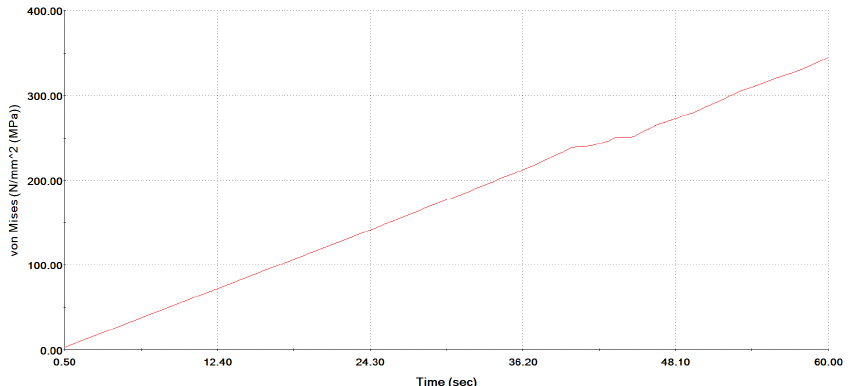
Figure 31. On the left, strain distributions EPSX on the x-axis are equal to ε x , and on the right, strain distributions EPSY on the y-axis are equal to ε y for the force ratio Fx:Fy = 1 in the final step of the simulation. Purple arrows show the direction of the load; green arrows show the virtual action of the slider.